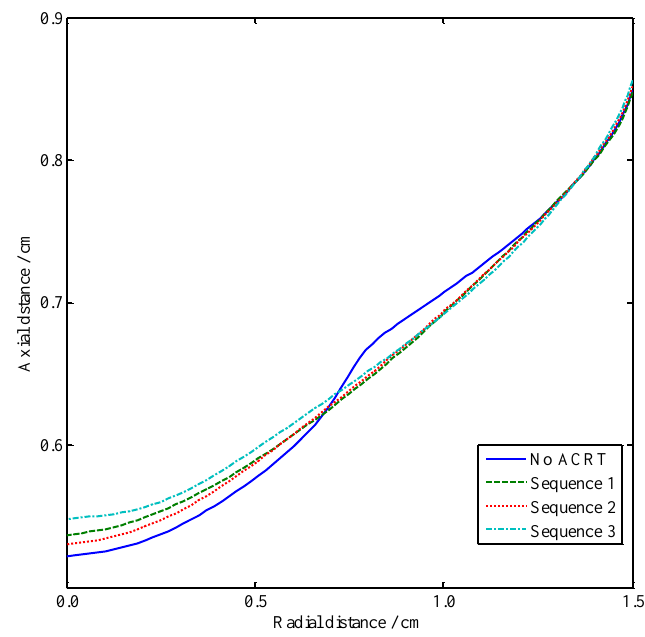
Figure 8. The growth interface morphology at about t = 26.2 h in the cases of no ACRT and of Sequences 1, 2, and 3.